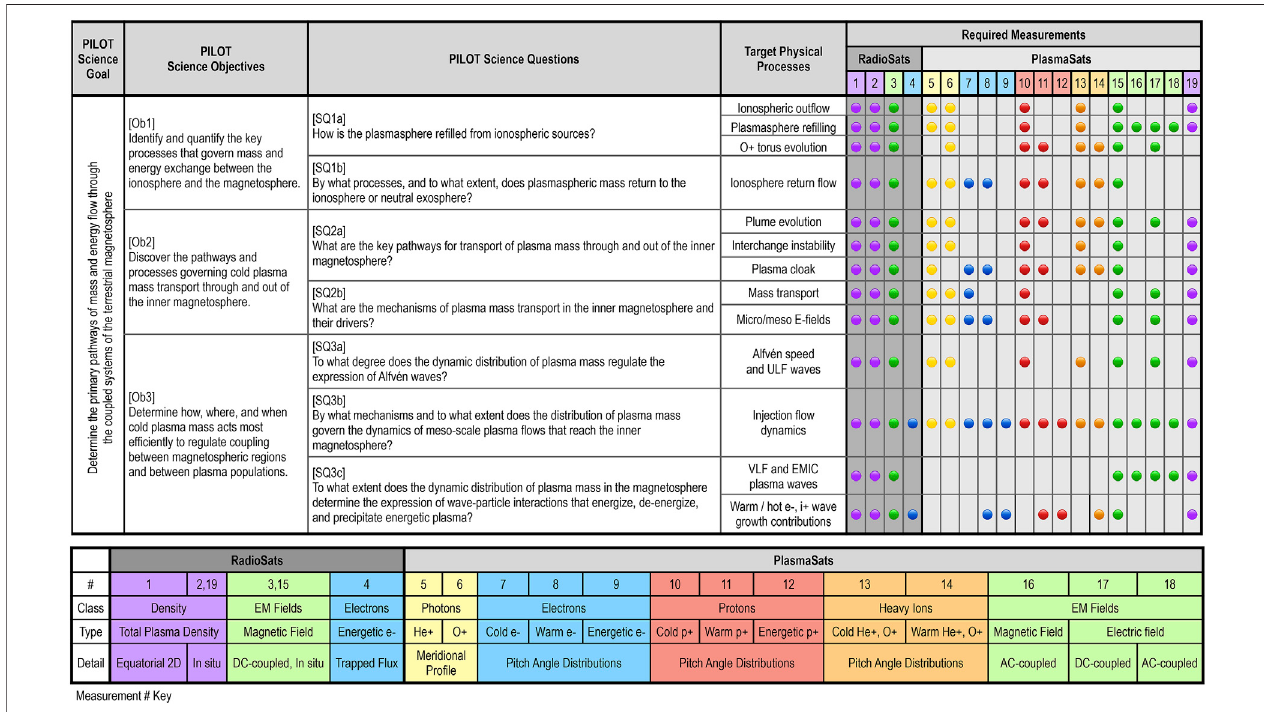
FIGURE 2 | Logical fl ow from PILOT science goal, to science questions, to targeted physical processes, to required measurements.